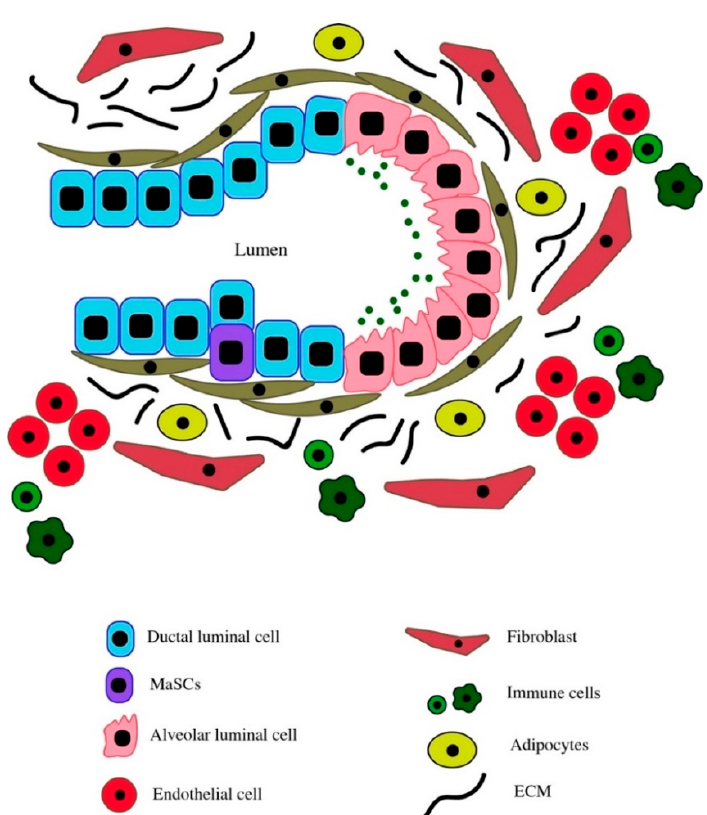
Figure 1. Schematic representation of the breast tissue microenvironment showing bilayered arrangement of ducts and alveolar structures consisting of luminal and myoepithelial cells. These structures are embedded in fibrous stroma consisting of fibroblasts, adipocytes, and immune cells. The luminal cells in the ducts are surrounded by a continuous lining of myoepithelial cells, while the myoepithelial cells lining the luminal cells in alveoli are discontinuous, which allows luminal cells to interact with surrounding stroma.